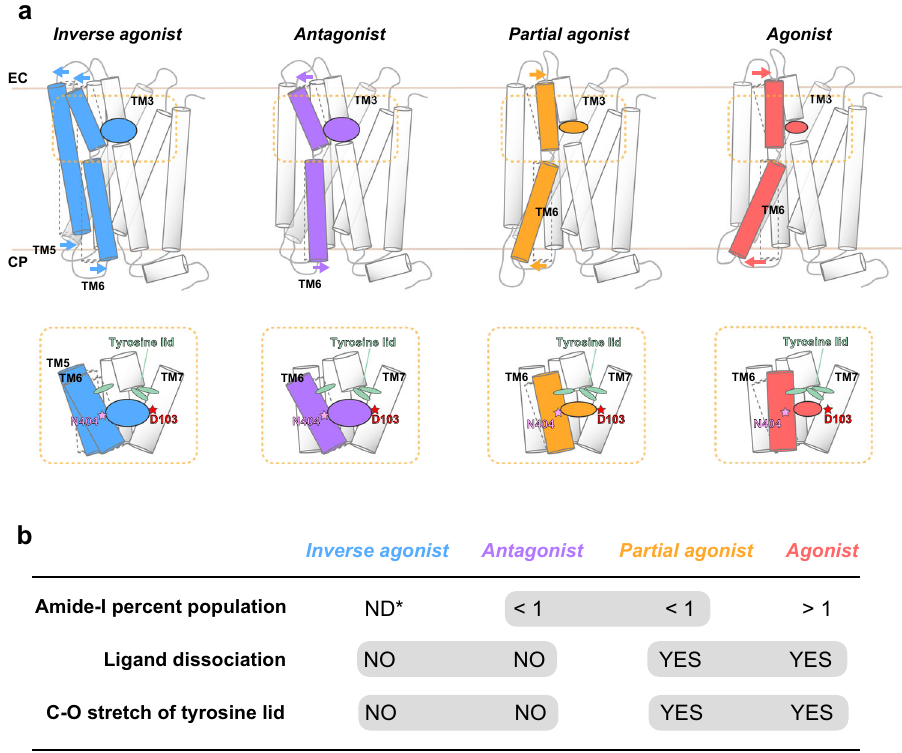
Fig. 5 Proposed conformational changes in M 2 R upon binding of ligands with different ef fi cacies. a (Upper) Schematic of M 2 R TM6 and TM5 conformational states upon binding of orthosteric ligands with different ef fi cacies. TM6 features an open conformation in the extracellular side and a closed conformation in the cytoplasmic side upon binding with inverse agonist and antagonist. In contrast, TM6 features a closed conformation in the extracellular side and an open conformation in the cytoplasmic side upon binding with both agonist and partial agonist, which causes the opposite movement with both inverse agonist and antagonist. Yellow dotted line indicates the orthosteric ligand binding pocket. (Lower) Schematic of M 2 R ligand binding pocket surrounded by TM3, 5, 6, and 7. Two key amino acids (Asn404 6.52 and Asp103 3.32 ) and tyrosine lid are depicted by star and oval markers, respectively. Binding of either inverse agonist or antagonist opens the extracellular region of TM6, resulting in loosening of the tyrosine lid, whereas both agonist- and partial agonist-bound forms compacts the ligand-binding pocket, which induces the formation of tyrosine lid that excludes solvent entry. b Summary of the differences in the ATR-FTIR analysis of M 2 R with various ligand ef fi cacies. By comprehensive comparing the three factors (amide-I band ratio, ligand dissociation, and C – O stretch of tyrosine lid) extracted from ATR- FTIR spectroscopy analysis, different ligand ef fi cacy can be